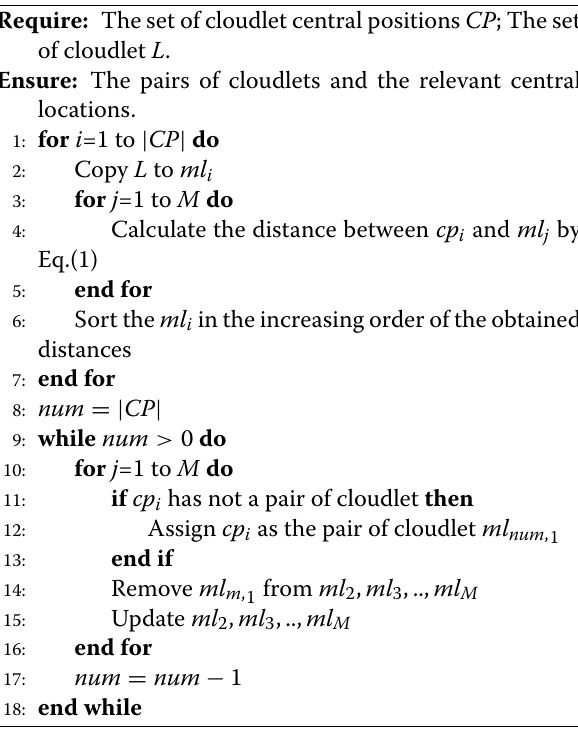
Algorithm 3 Cloudlet-location pair matching ( CP , L ) Algorithm 4 Dynamic cloudlet